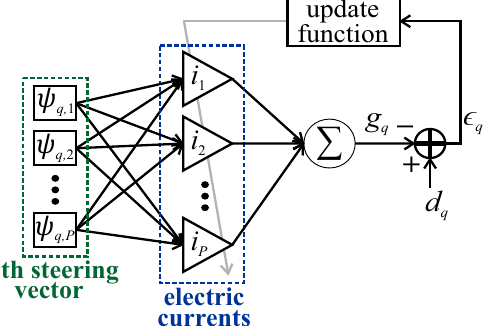
Figure 2. Least mean square (LMS) architecture for